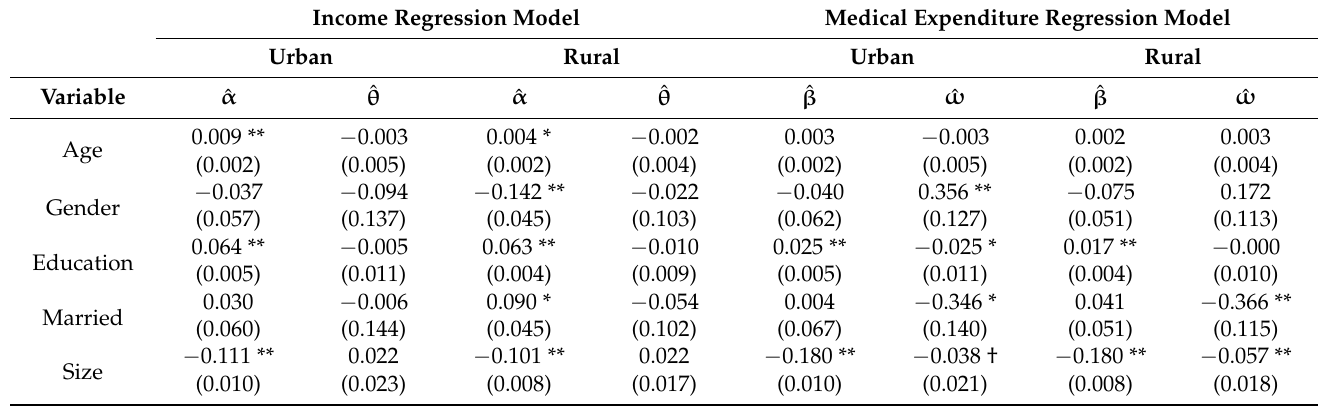
Table A1. The results of FGLS estimation for income and medical expenditure regression